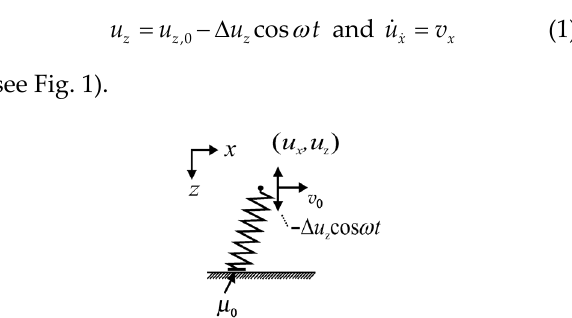
Fig. 1 The simplest model of a tribological contact with a con- stant contact stiffness represented as a single spring, which has a k and a tangential stiffness k . The upper end normal stiffness z x of the spring is forced to move according to Eq. (1). At the lower end (immediate contact spot), Coulomb’s law of friction with a constant coefficient of friction  is 0